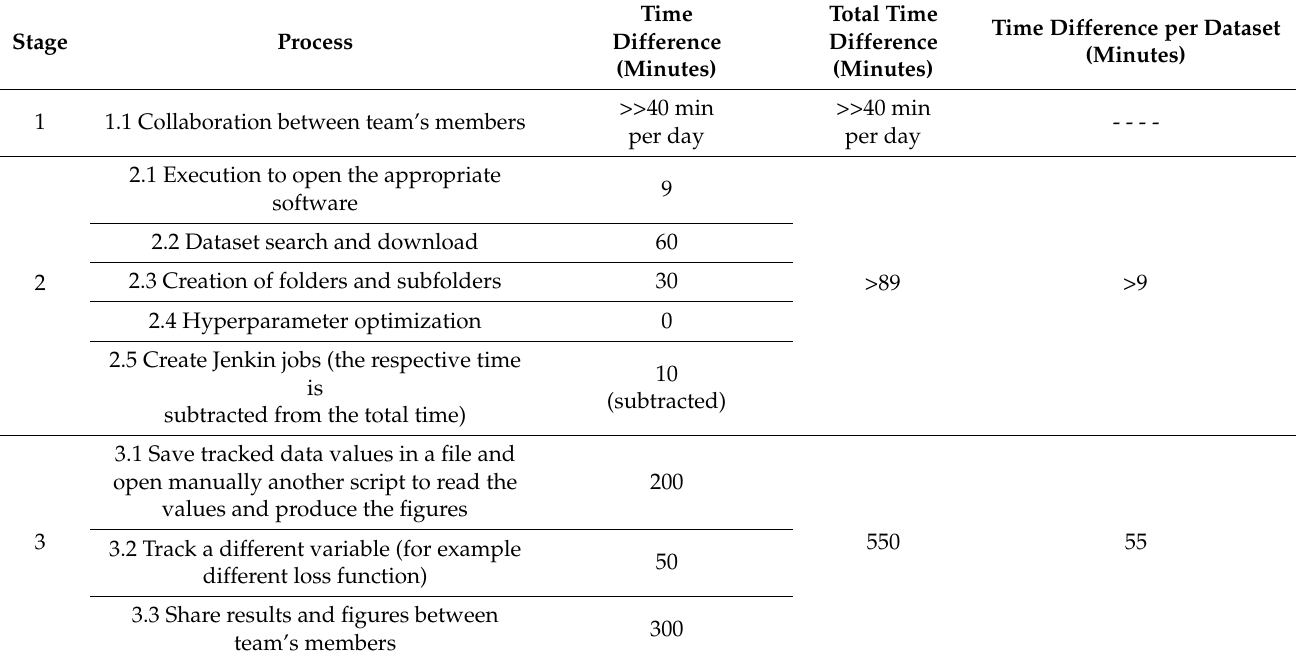
Table 12. Estimated time differences between the automated execution using the proposed AutoML system and the manual execution of nine individual processes involved in the pipeline illustrated in Figure 2 (the time differences are translated as the time saved by the implementation of the proposed